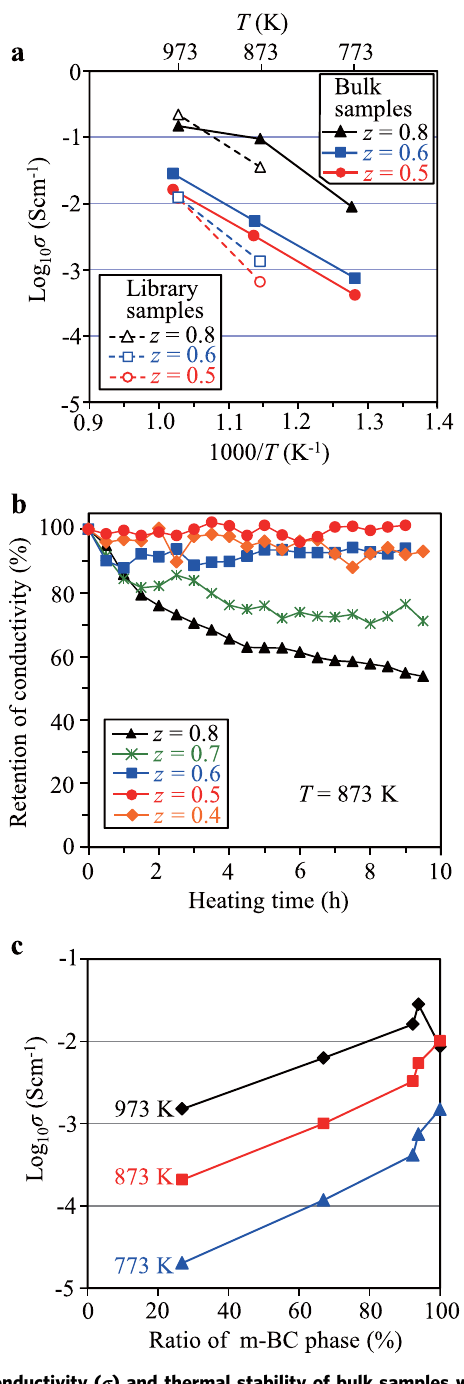
Fig. 4 Conductivity ( σ ) and thermal stability of bulk samples with the composition [Ca x (Nb 0.6 Ta 0.4 ) 1 − x ] 1 − z Bi z O δ . a Comparison of ionic conductivity in library and bulk samples as a function of temperature. b Retentions of conductivity in bulk samples with typical compositions at 873K as a function of heating time. c Conductivities of [Ca x (Nb 0.6 Ta 0.4 ) 1 − x ] 1 − z Bi z O δ bulk samples as a function of m-BC phase